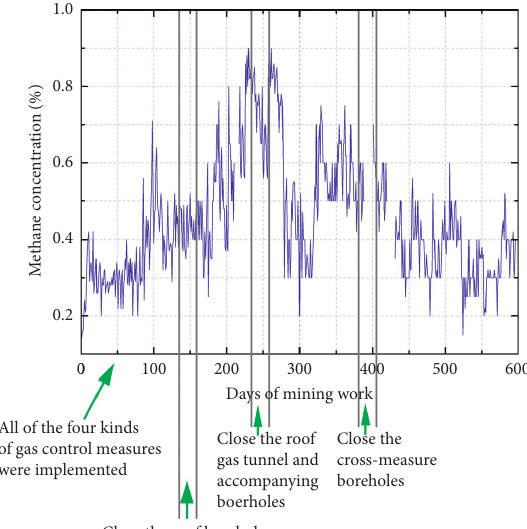
Figure 14: Variations of methane concentration when using different gas drainage measures in No. 21024 panel (particularly, at the corner of working face).